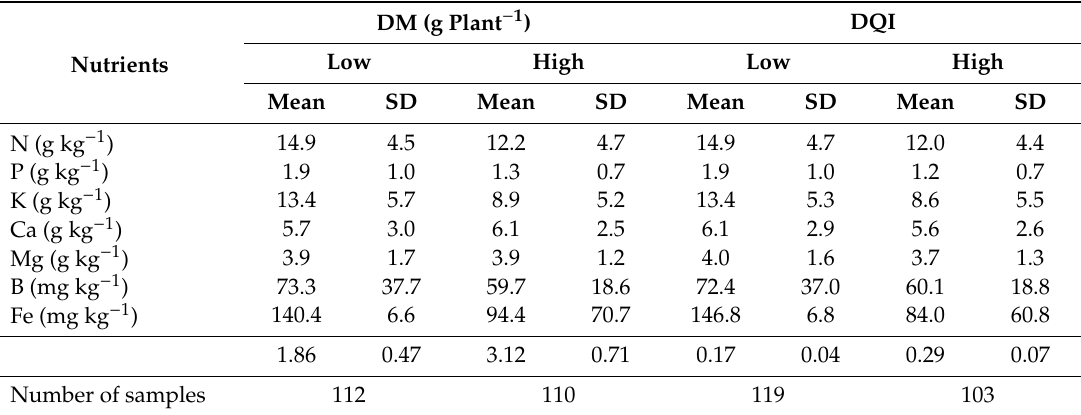
Table 3. Mean and standard deviation (SD) of nutrient content (N, P, K, Ca, Mg, B and Fe), in whole plant dry matter (DM) and the Dickson quality index (DQI) of high and low-yield subpopulations of Eucalyptus spp. clonal rooted cuttings of commercial